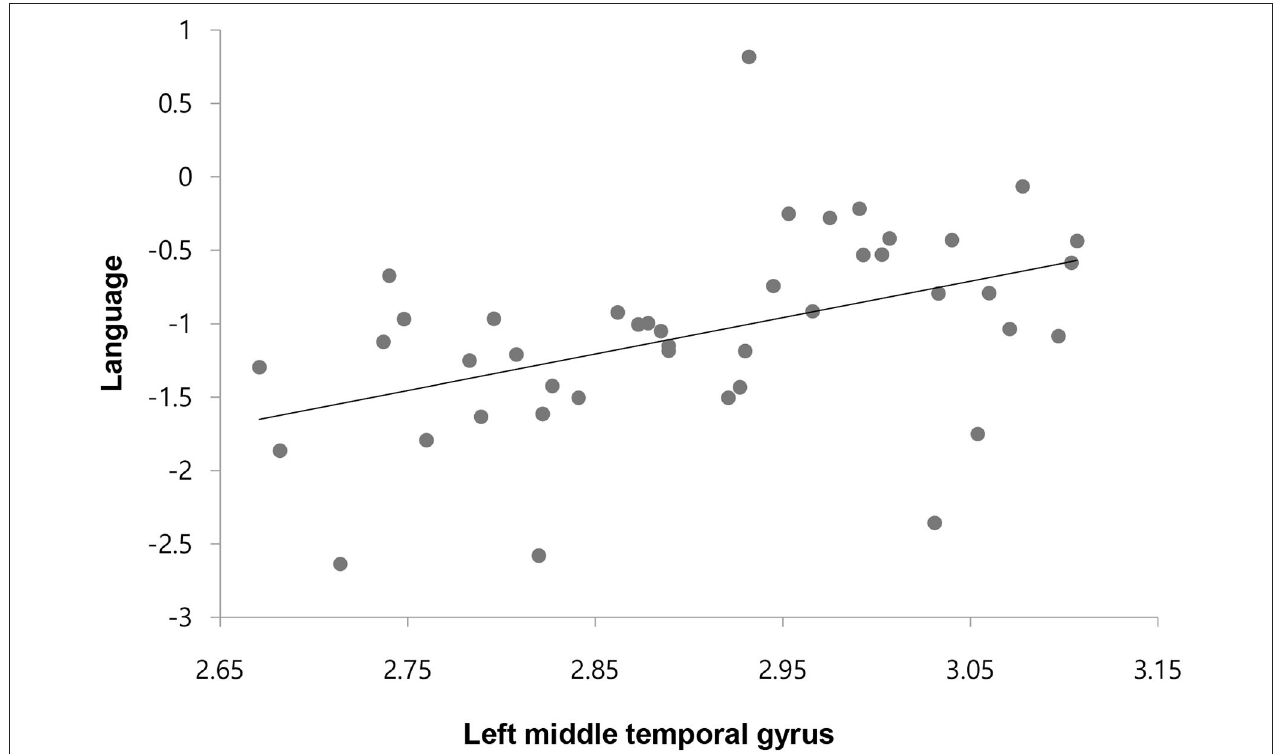
FIGURE 2 | Correlation between the cortical thickness of left middle temporal gyrus and composite score of language in patients with early-stage